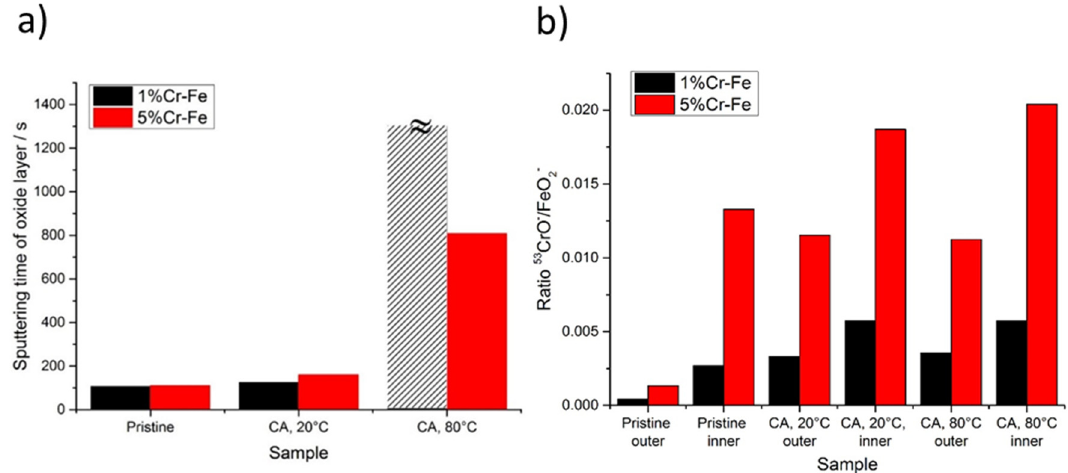
Figure 11. ( a ) ToF-SIMS sputtering time corresponding to thickness of the oxide layer for pristine samples and after polarization (chronoamperometric measurements) for 1% and Fe-5% Cr alloys; ( b ) ToF-SIMS CrO − /FeO 2 − intensity signal ratio for pristine sample and after polarization for 1% and Fe-5% Cr alloy samples measured in the beginning of sputtering time (outer layer) and at the oxide/alloy substrate interface (inner layer).